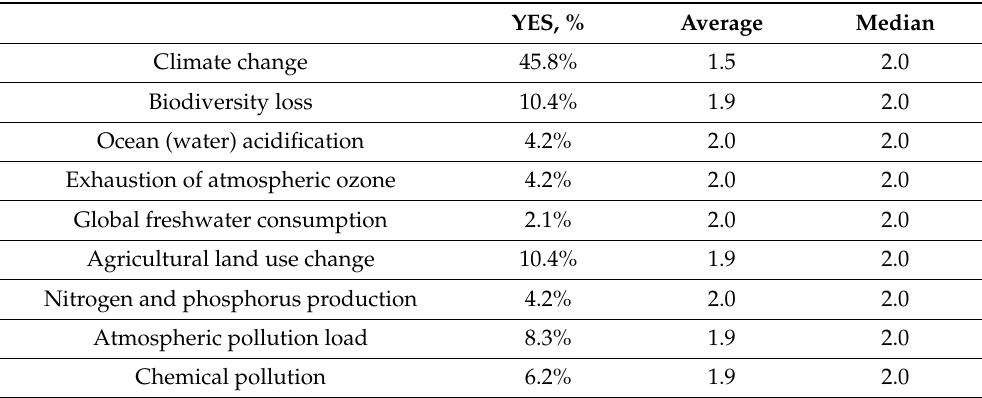
Table 5. Indicate whether your company has specific actions in place to address the following environmental issues ( n = 48) (source: authors’ calculation).